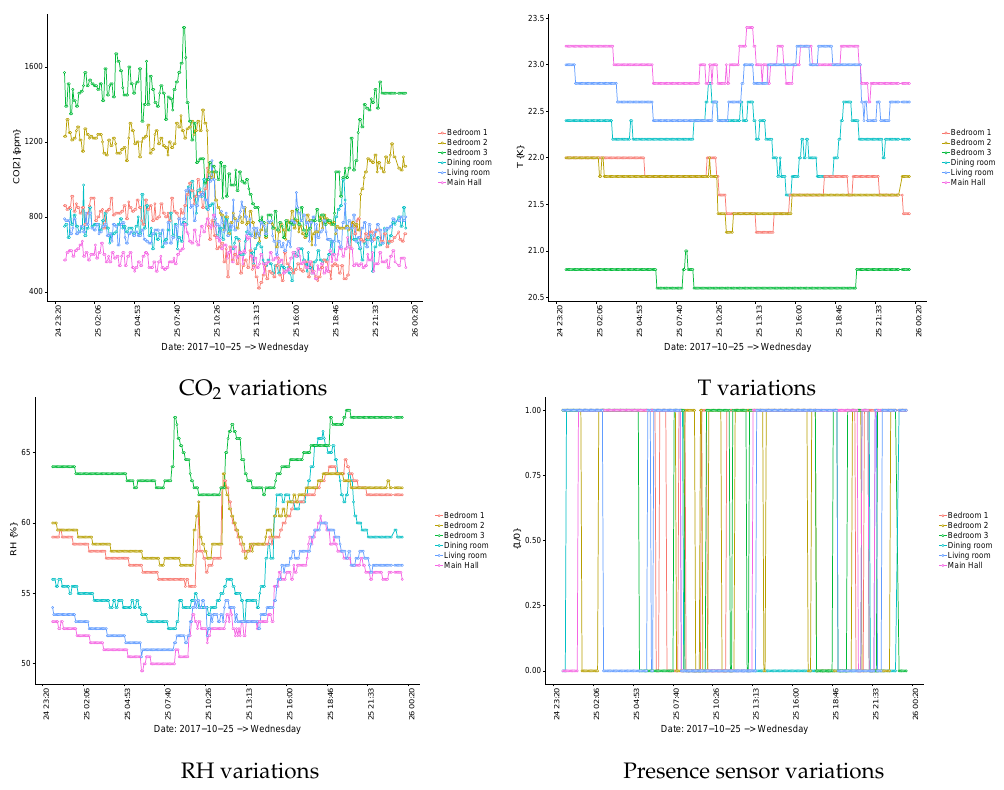
Figure 4. Sensor variations per room on 25 October